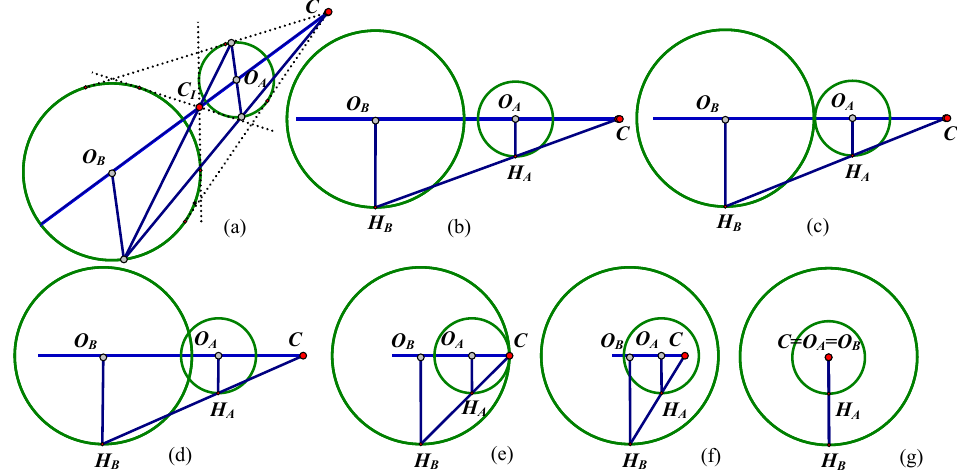
Figure 1. The external homothetic center C (or the internal homothetic center C I ) of: two ( a , b ) sep- aration circles; ( c ) externally tangent circles; ( d ) intersecting circles; ( e ) internally tangent circles; ( f ) containing circles; ( g ) concentric